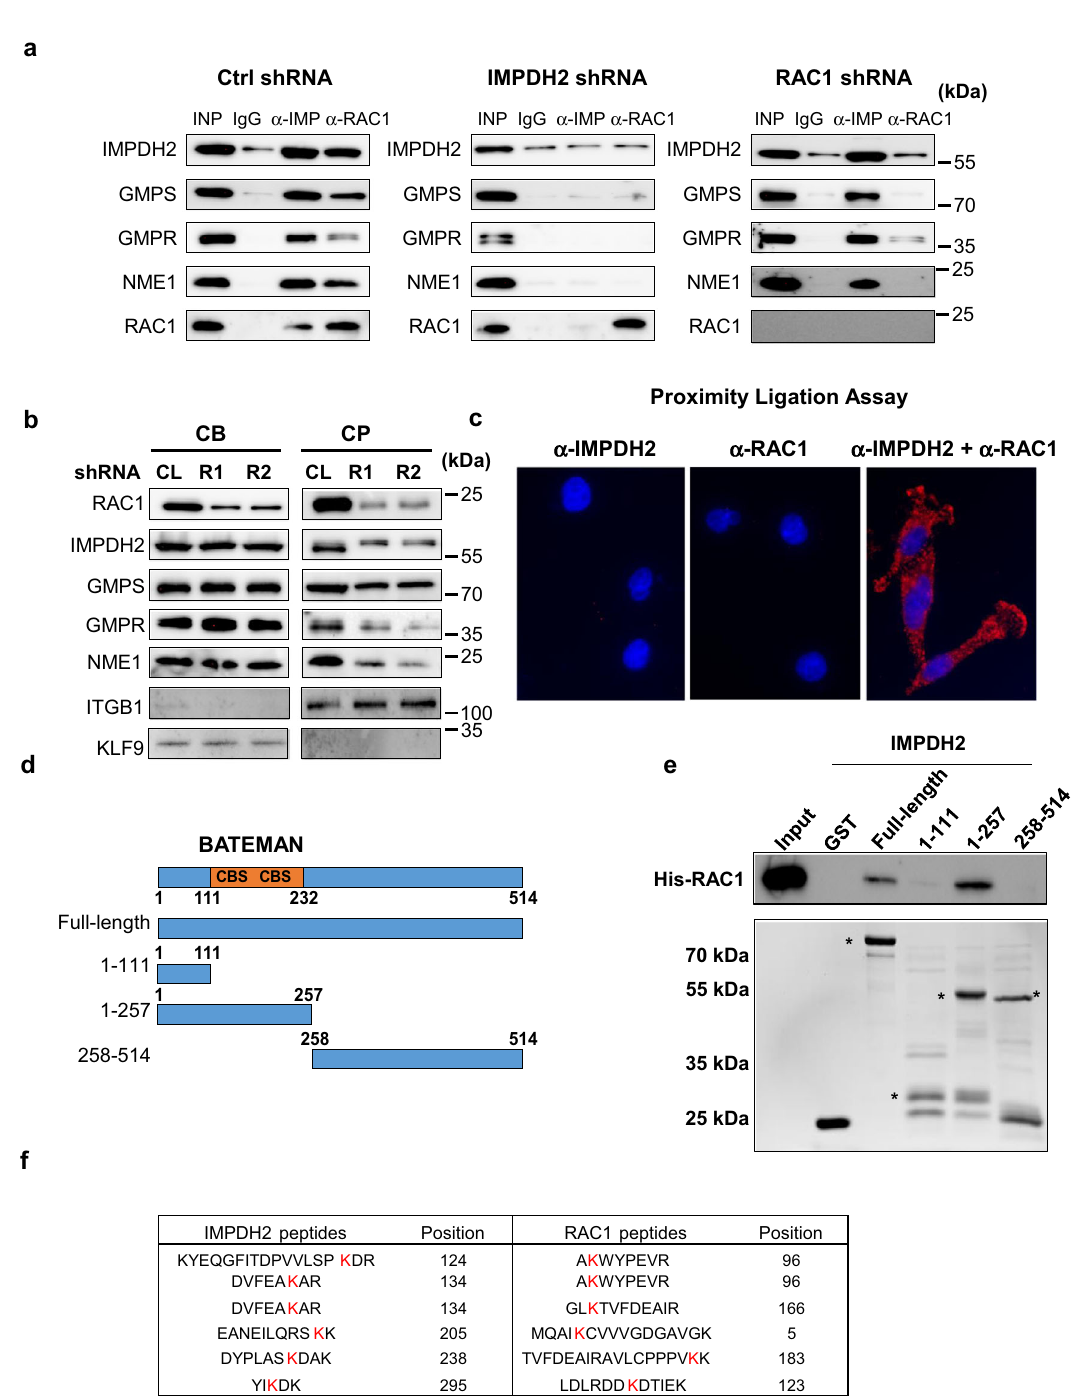
Fig. 4 RAC1 interacts with IMPDH2 and recruits GMPS. a Cells were transduced with the indicated constructs and subjected to immunoprecipitation with the antibodies indicated on the top. The immunoprecipitated materials were probed in immunoblotting with the antibodies indicated on the left. Shown are representative images of at least two independent experiments. b Cells were fi xed with ice-cold methanol and separated into cell bodies (CB) or cell protrusions (CP) fractions, followed by immunoblotting with the indicated antibodies. Shown are representative images of two independent experiments. c Proximity ligation assay was performed on sparsely plated cells with the antibodies indicated on the top. Shown are representative images of two independent experiments. d Schematic representation of IMPDH2 deletion mutants. Shown are Bateman domain consisting of two cystathionine- β - synthase sequences (CBS). e Indicated GST-tagged recombinant IMPDH2 mutants were incubated with recombinant 6xHis-tagged RAC1 (shown on the top), followed by immunoprecipitation with anti-GST tag antibodies and immunoblotting with anti-RAC1 antibodies. Shown are representative images of two independent experiments. f Recombinant full-length IMPDH2 and RAC1 proteins were cross-linked followed by mass spectroscopy as described in Methods. Shown are intra-proteins cross-linked peptides identi fi ed with highest con fi dence. Highlighted in red are cross-linked lysines. Shown are representative gel images of at least two independent